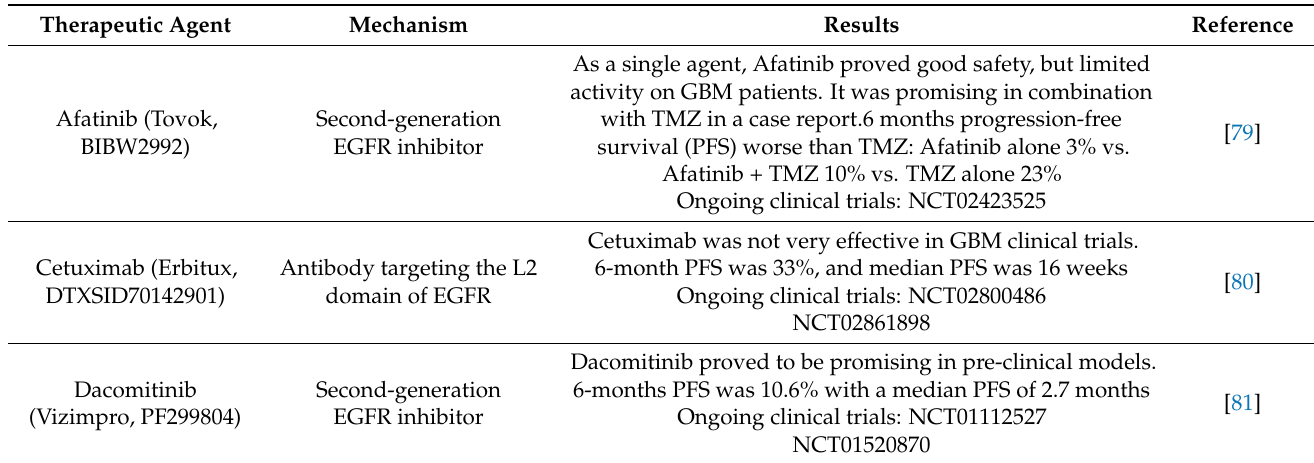
Table 1. Epidermal growth factor receptor (EGFR)-targeted therapies for adult high-grade gliomas currently in investiga- tional and/or clinical use. Therapeutic Agent Mechanism Results